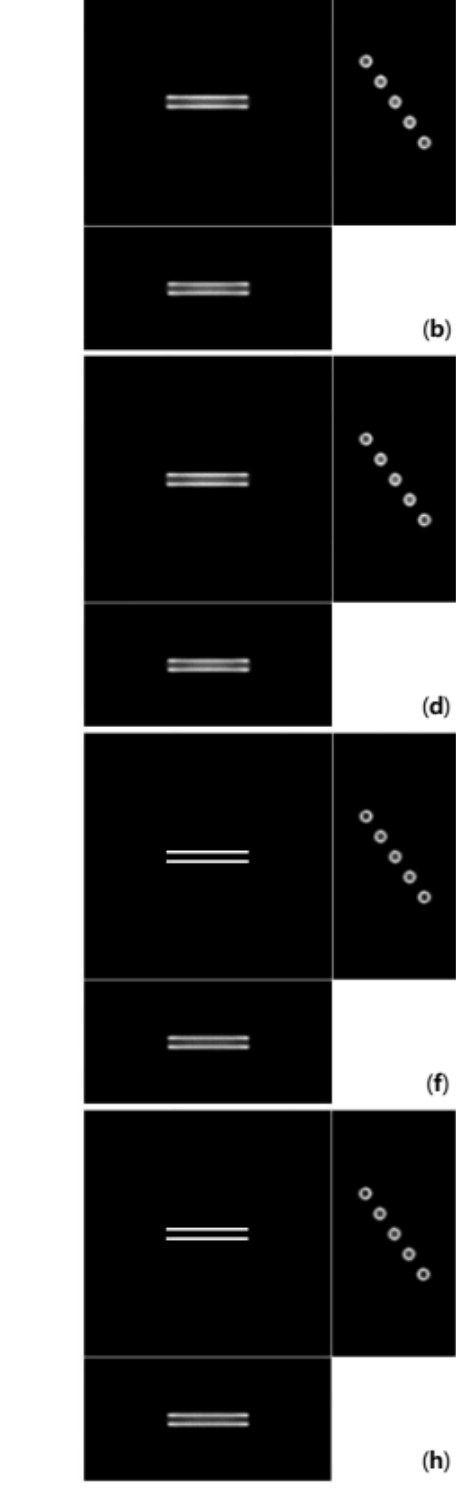
Figure 6. Deconvolution results using the ( a ) depth-invariant symmetric OSL algorithm, ( b ) depth-invariant symmetric GEM algorithm, ( c ) depth-variant symmetric OSL algorithm, ( d ) depth-variant symmetric GEM algorithm ( e ) depth-variant symmetric OSL algorithm, ( f ) depth-variant asymmetric GEM algorithm, ( g ) depth-variant asymmetric OSL algorithm, and ( h ) depth-variant asymmetric GEM algorithm on the 15 dB Gaussian noise